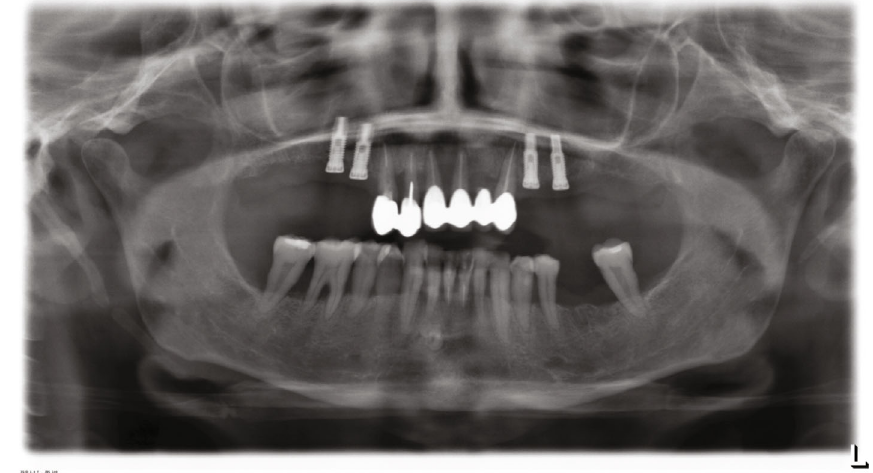
Figure 2: Orthopantomography performed in